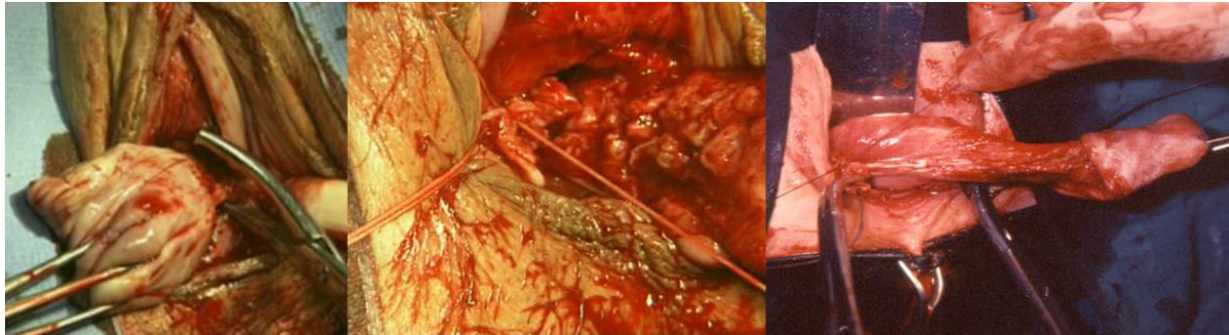
Figure 5. On the left, the exposure of the uterine artery; in the center, the ligation of the uterine vessels after cutting it; on the right, the dissected and tied uterine arteries.